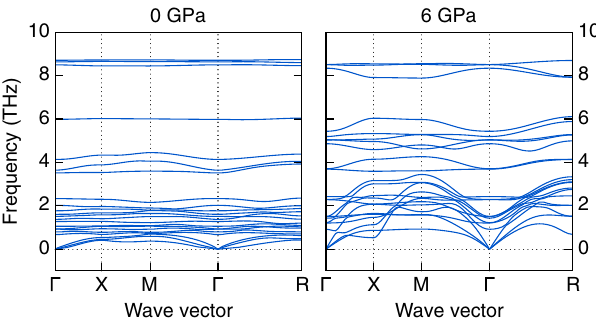
Fig. 3 Phonon dispersion of R3m N(CH 3 ) 4 SnI 3 under 0 and 6 GPa. The high-symmetry wave vectors are Γ (0, 0, 0), X (0, 1/2, 0), M (1/2, 1/2, 0), and R (1/2, 1/2,